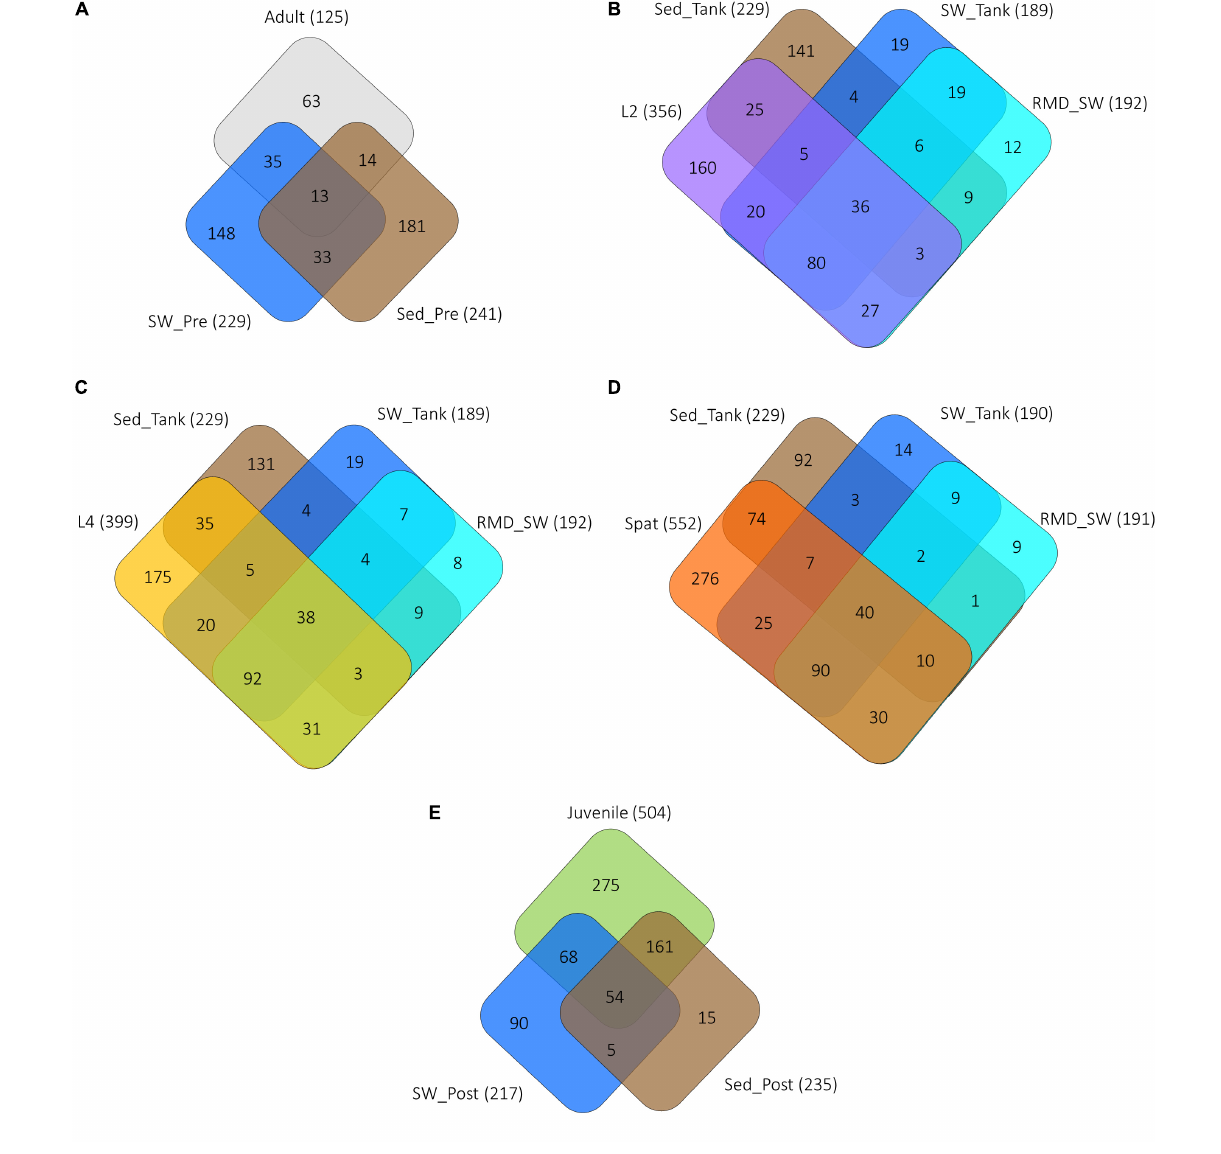
(Schmitt et al., 2008; Webster et al., 2010), solemyid bivalves (Russell et al., 2017), and humans (as reviewed in Ebert,